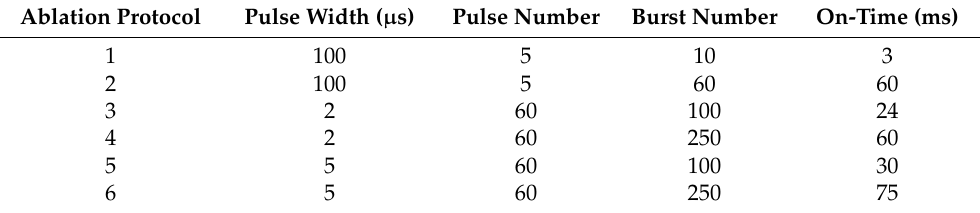
Figure 1. Electroporation equipment for ablation experiments. ( A ) Cuvette with 4 mm gap. ( B ) Ad- herent cell custom-printed probe. ( C ) Biphasic pulse waveform. Table 1. Ablation protocols applied to different models of cardiac cell culture.